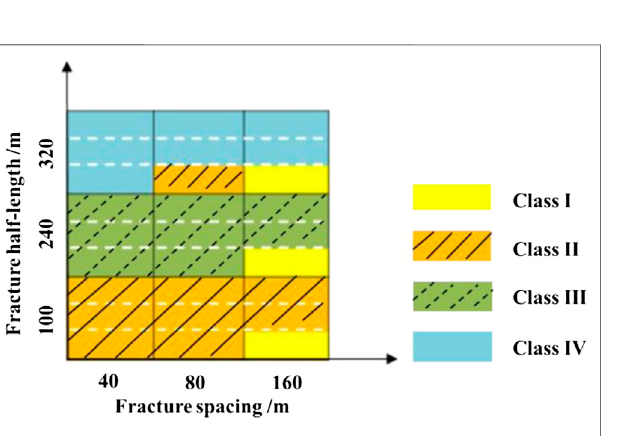
FIGURE 7 | Chart of refracturing timing at different primary fracturing